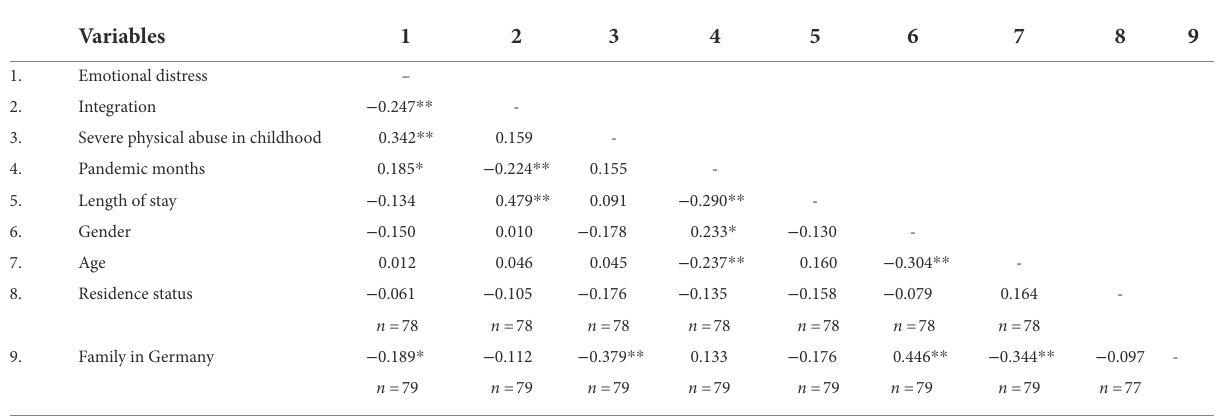
TABLE 1 Kendall’s tau correlations.